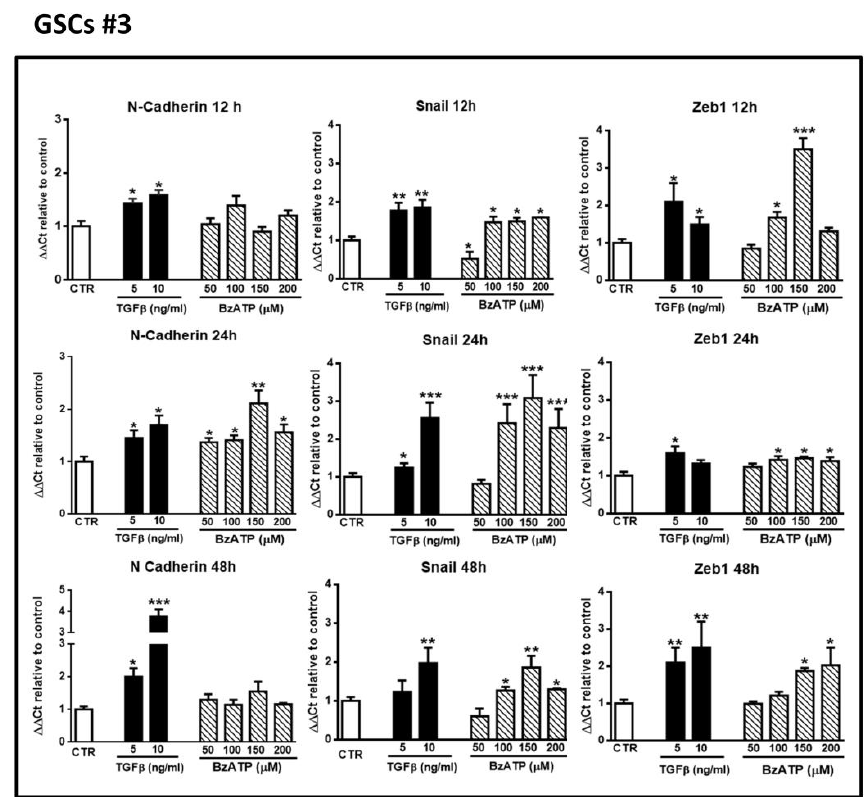
Figure 3. Effect of TGFβ1 or BzATP on EMT markers evaluated by qRT -PCR at different times after drug administration to cultured GSCs #3. Similar to what is reported in the legend of the Figure 2, confluent GSCs were exposed to TGFβ1 or BzATP for the indicated times, at the end of which cells were collected and their mRNA was analyzed for the gene expression of EMT markers. mRNA levels were normalized (ΔCt) by using the house keeping GAPDH as endogenous control and the results were analyzed for relative quantitation among groups using the comparative 2 ΔΔCt method. Values, calculated as fold of increase vs. untreated cells assumed as control (CTR) are the mean ± S.E.M. of three independent experiments in which each sample was tested in duplicate. * p < 0.05, ** p < 0.01, *** p < 0.001: statistical significance vs. CTR (one-way ANOVA plus Dunnett’s test).